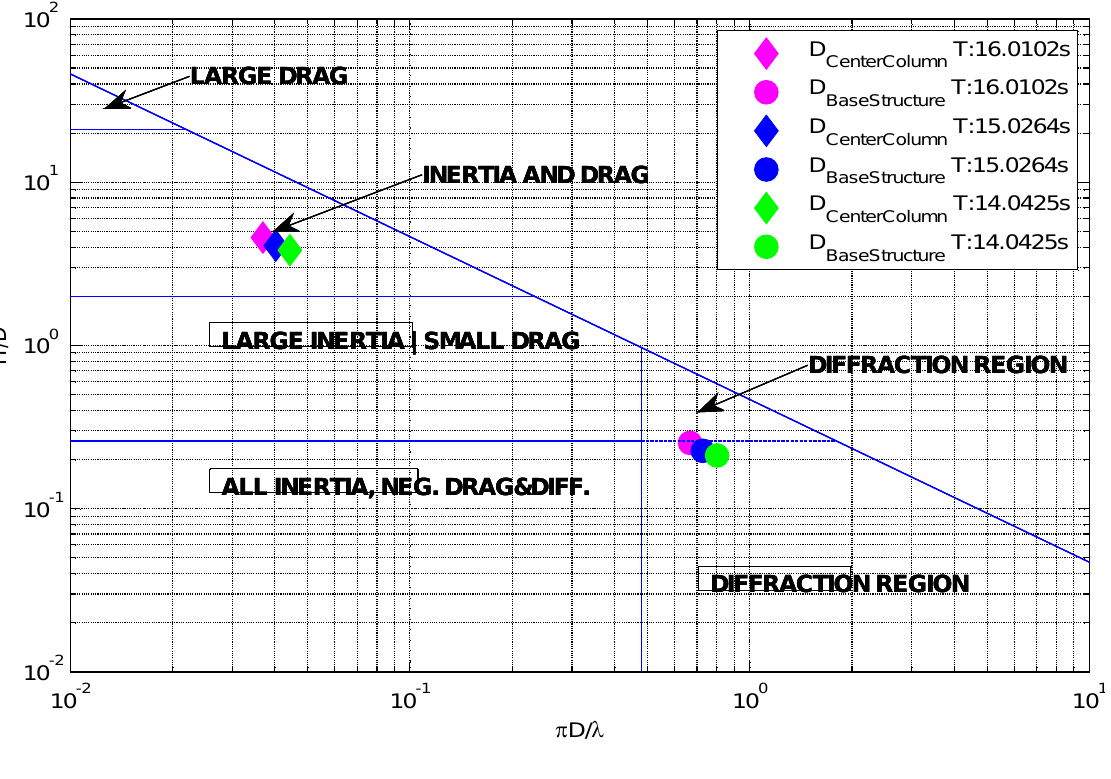
Figure 3. Non-dimensional ratios of inertial and viscous loads for dominating structural parts